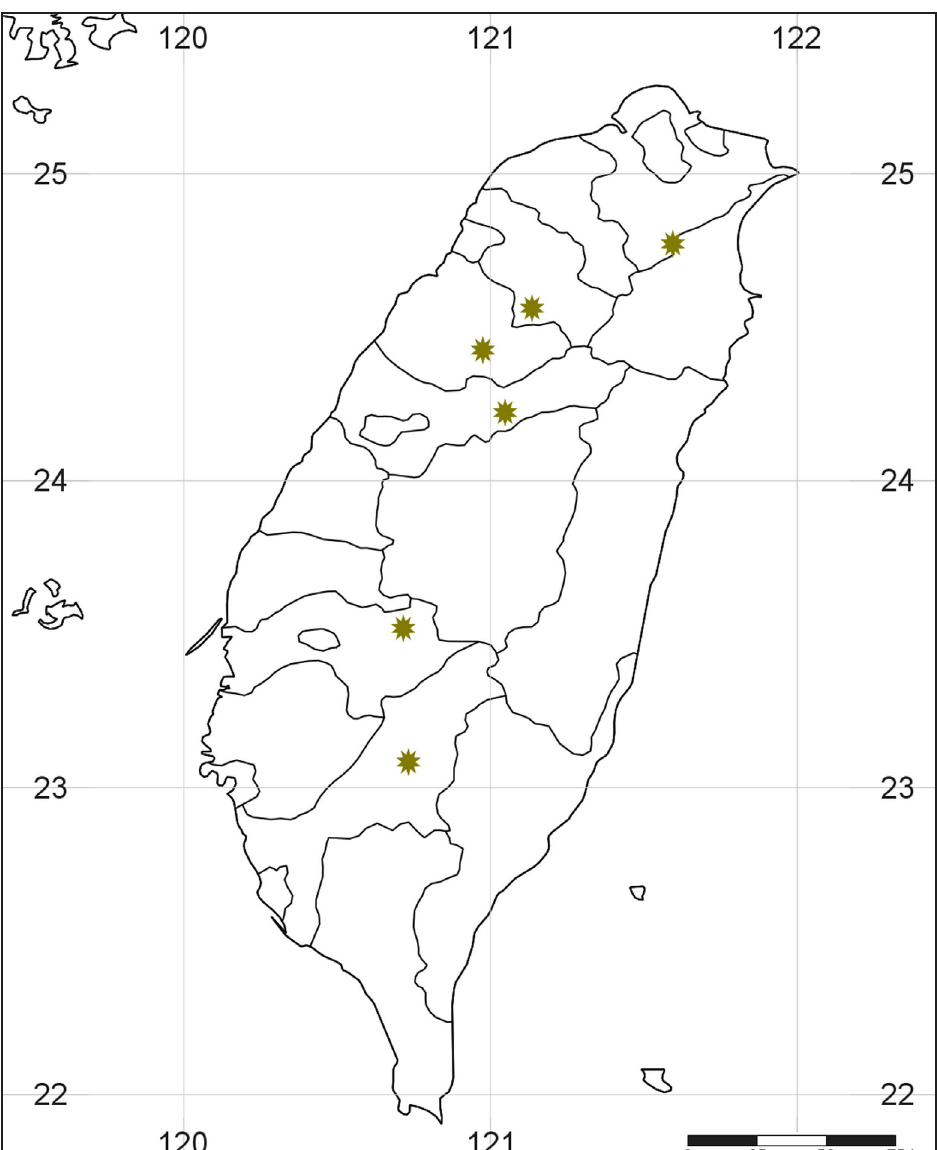
Fig. 8. Distribution map of Synchroa formosana Hsiao, 2015 from